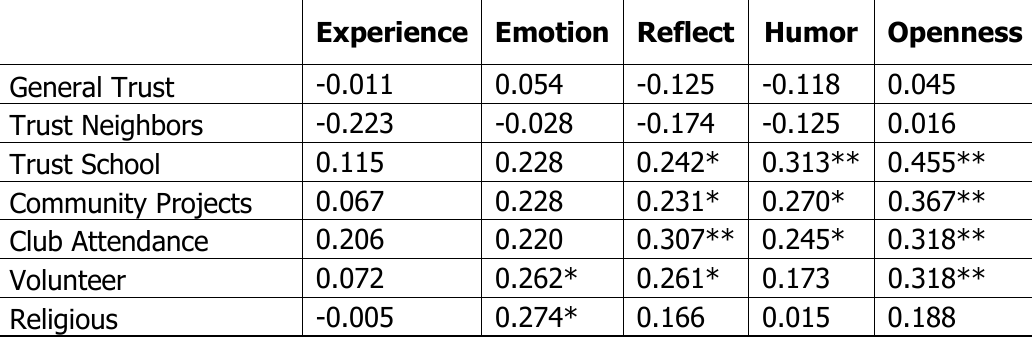
Correlations of Social Capital Items and Wisdom